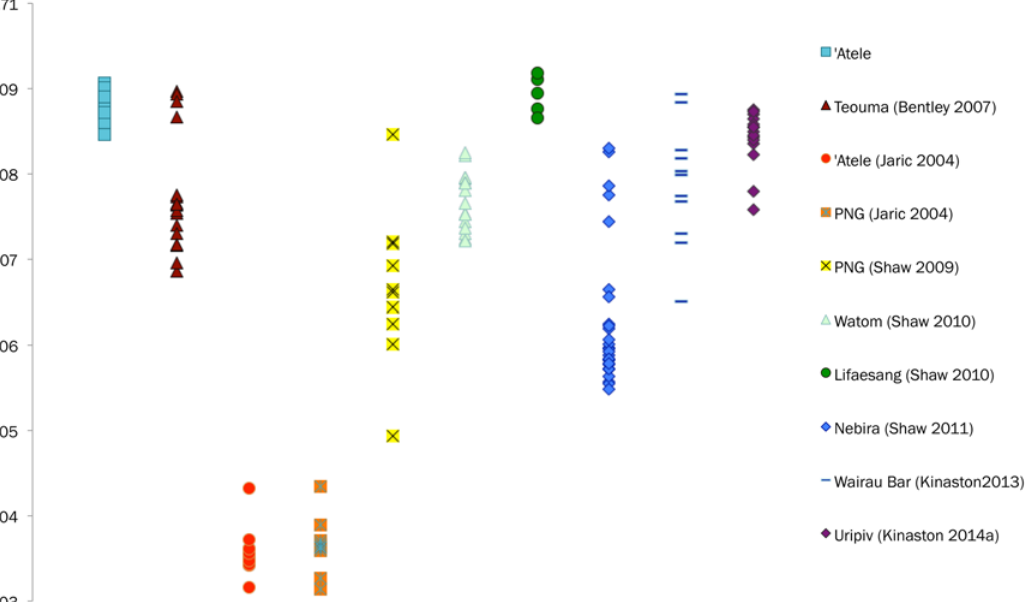
Fig 11. The `Atele 87 Sr/ 86 Sr ratios produced in this study compared to the 87 Sr/ 86 Sr ratios from previous prehistoric Pacific studies [78 – 82,101,102] Note the lower 87 Sr/ 86 Sr ratios by Jaríc